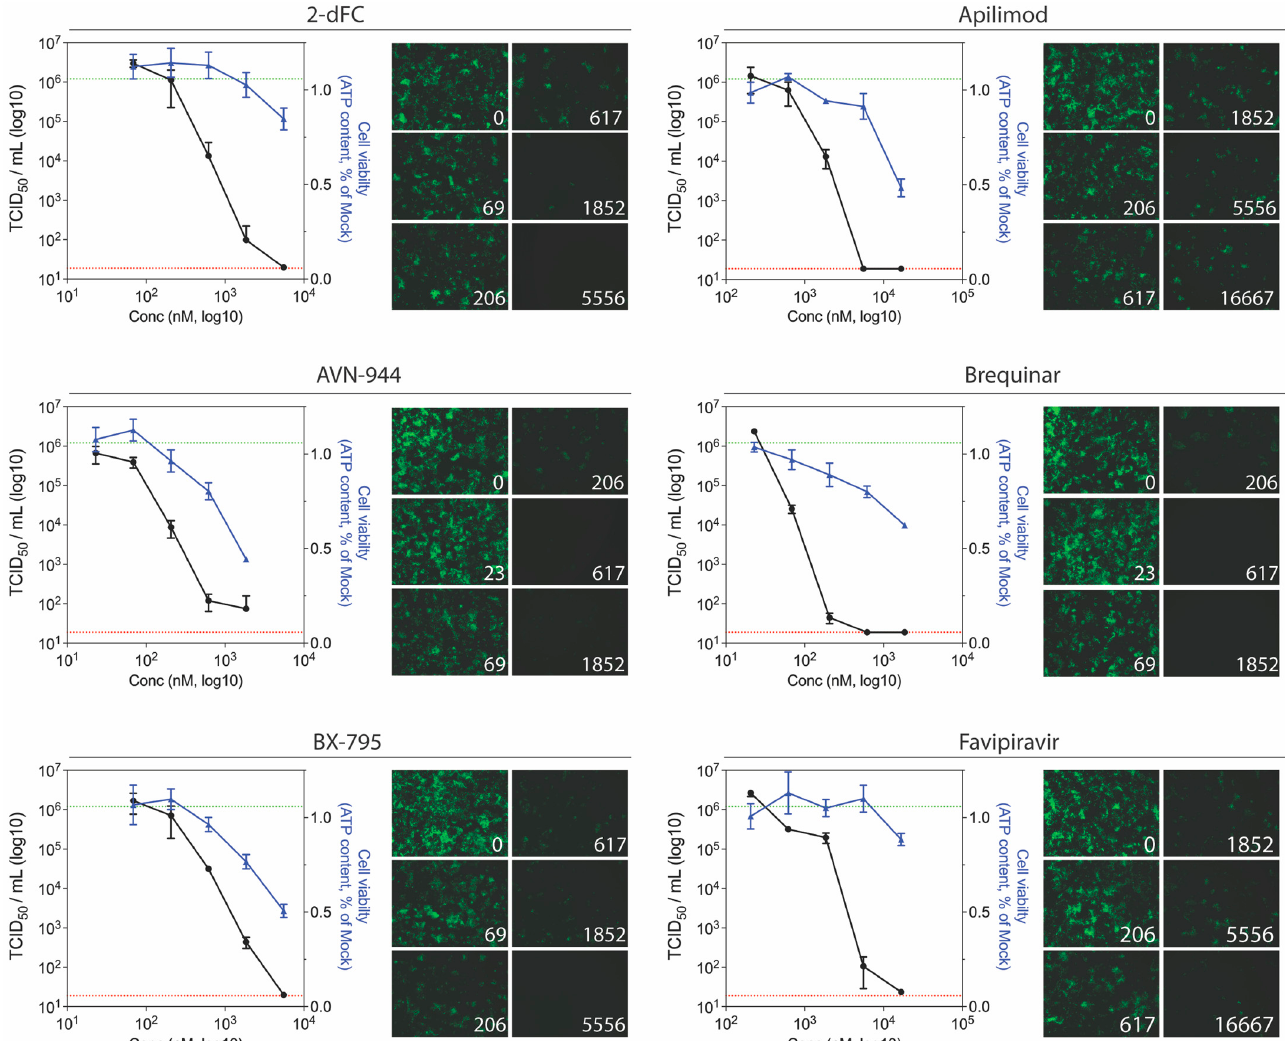
Figure 5. Ability of the most potent anti-LUJV compounds to inhibit wild-type virus replication. Titer reduction assays using wt LUJV were performed in Huh7 cells treated with varying concentrations of indicated compound 1 h prior to infection (MOI 0.1). For each compound concentration, inhibition of rLUJV/ZsG and cell viability were concurrently assessed. Four days post-infection, cell culture supernatants were collected and LUJV titers (TCID 50 /mL) were determined in Vero-E6 cells by immunofluorescence assays. For each concentration, LUJV titers (black) and cell viability (blue) are shown. Dotted lines represent the limit of detection for the TCID 50 assay (red) and the mean wt LUJV titer in mock-treated (DMSO only) cells (green). Each point represents the mean of quadruplicate wells, with error bars indicating standard deviation; graphs are representative of at least 3 independent experiments. ZsG fluorescence in rLUJV/ZsG-infected Huh7 cells at each compound concentration is also shown (10 × magnification).